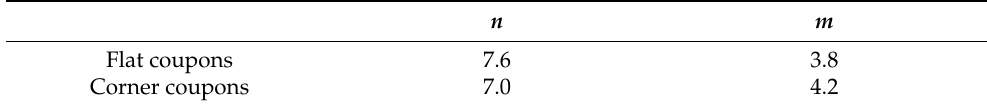
Table 1. Strain-hardening